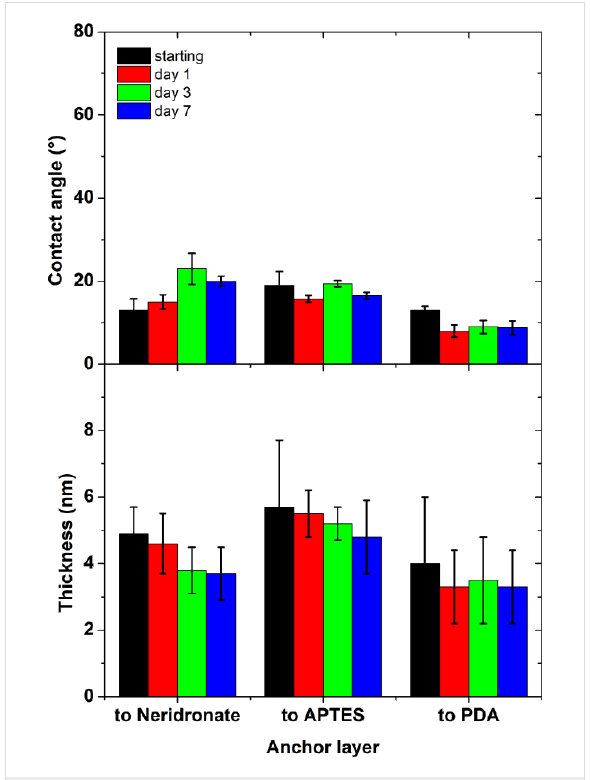
Figure 7: Ellipsometric thickness and water contact angle evolution of ALG bound to neridronate, APTES siloxane and PDA during the immersion in PBS (37 °C, pH = 7.4) (mean value ± SD, n =